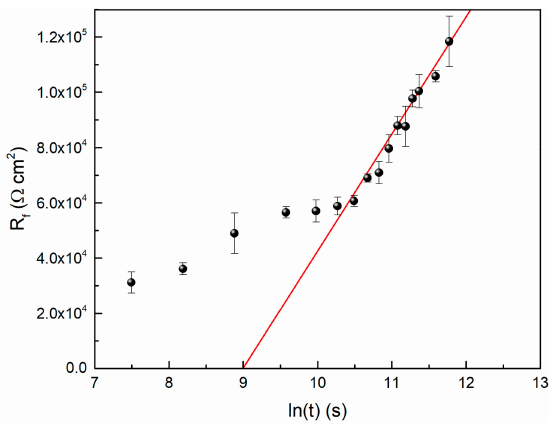
Figure 7. The logarithmic growth behavior of passive film on TC11 Alloy in 0.01 M Na 2 SO 4 . If it is assumed that the film resistance is a function of its thickness (that is Equation (3)), then the slope of the fitted line can be used to calculate the value of ε . When the value of ρ is 10 6 Ω · m, the result of ε is equal to 3.09 × 10 6 V / cm. Generally, the order of magnitude of the electric field strength of passive film is 10 6 V / cm